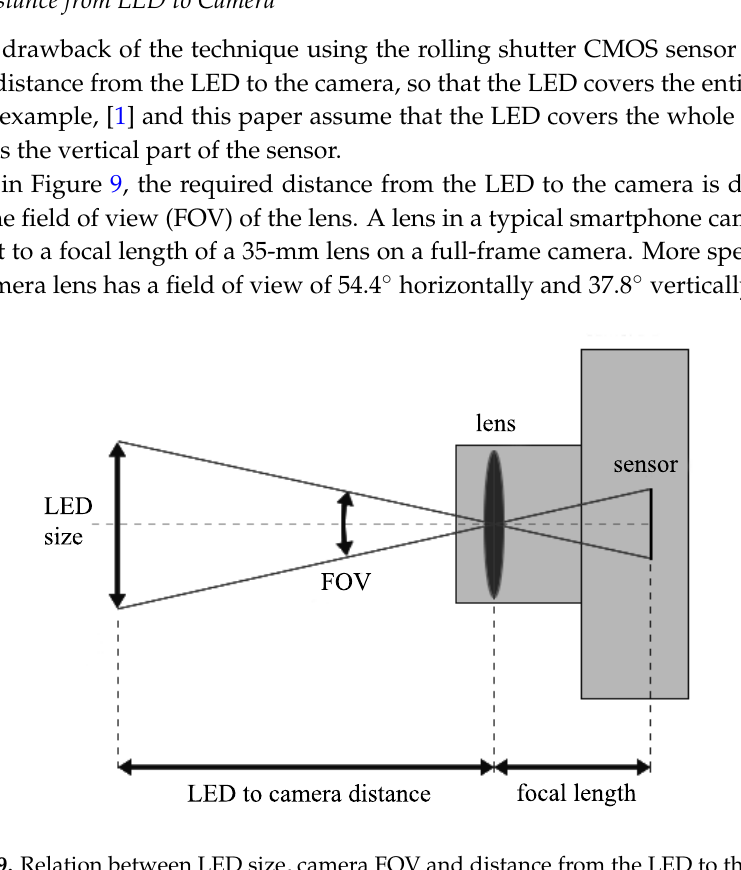
Figure 9. Relation between LED size, camera FOV and distance from the LED to the